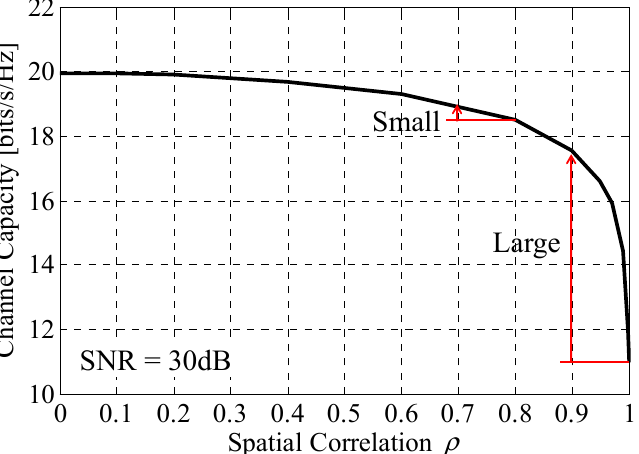
Figure 6. Channel capacity vs. spatial correlation.